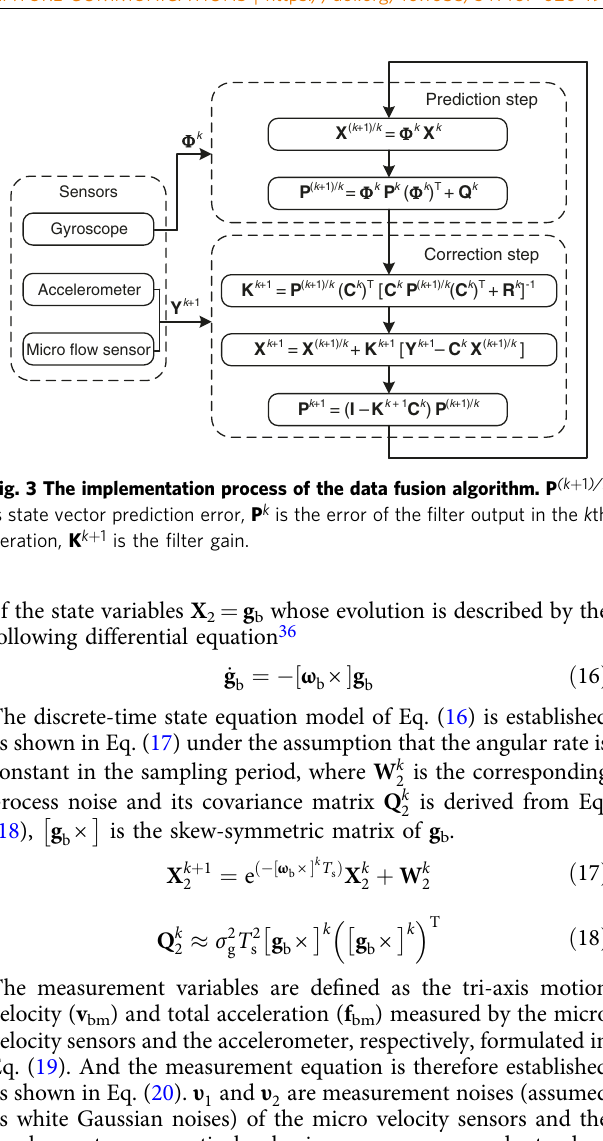
The experimental results of the forearm and shank motion capture in boxing and kicking motions are shown in Fig. 4 and Fig. 5, respectively. The motion capture performance is summarized in Supplementary Table 1. High dynamics of boxing and kicking are observed, the motion acceleration in boxing and kicking exceeds 120 m/s 2 and 100 m/s 2 , respectively, as shown in Fig. 4b and Fig. 5b. The result of the magnitude of motion acceleration measured using our device is consistent with that of the optical VICON, whose error is obviously less than that using the conventional inertial method as shown in Fig. 4c and Fig. 5c. The measurement results of tri-axis motion velocity are shown in Fig. 4d and Fig. 5d, where the measurement error of velocity using our device is only less than 0.11 m/s, and the results of conventional inertial method 30 exhibit unbounded drift errors shown in Fig. 4e and Fig. 5e. Results also indicate that the measurement errors of attitude angles determined by our device are greatly less than that of the inertial method. Speci fi cally, the root-mean-square error (RMSE) of attitude angles by our device is less than 1.70°, which halves the error of the inertial method. And the drift error of attitude angles using our device is negligible as the mean error (ME) is less than 0.47°. inertial method is larger, the ME reaches 3.19° and the RMSE